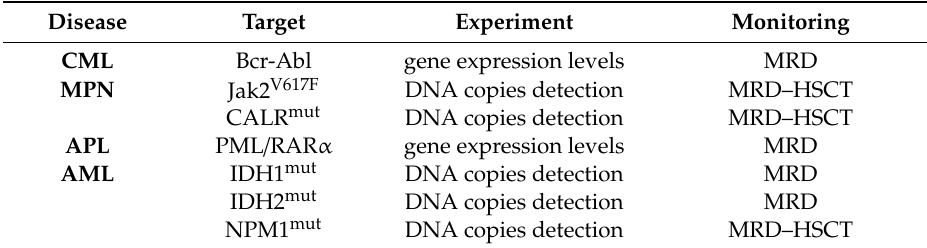
Table 1. A summary of the main targets analyzed by dPCR and